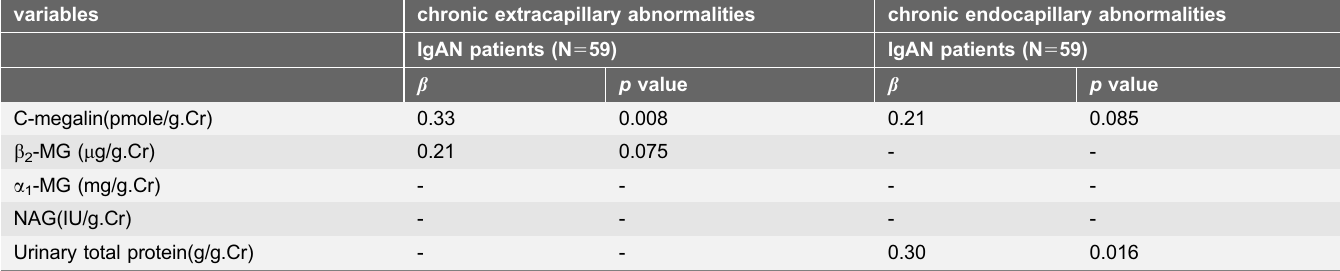
Table 4. Stepwise multiple regression analysis of histological variables in the Shigematsu classification with relevant factors. variables